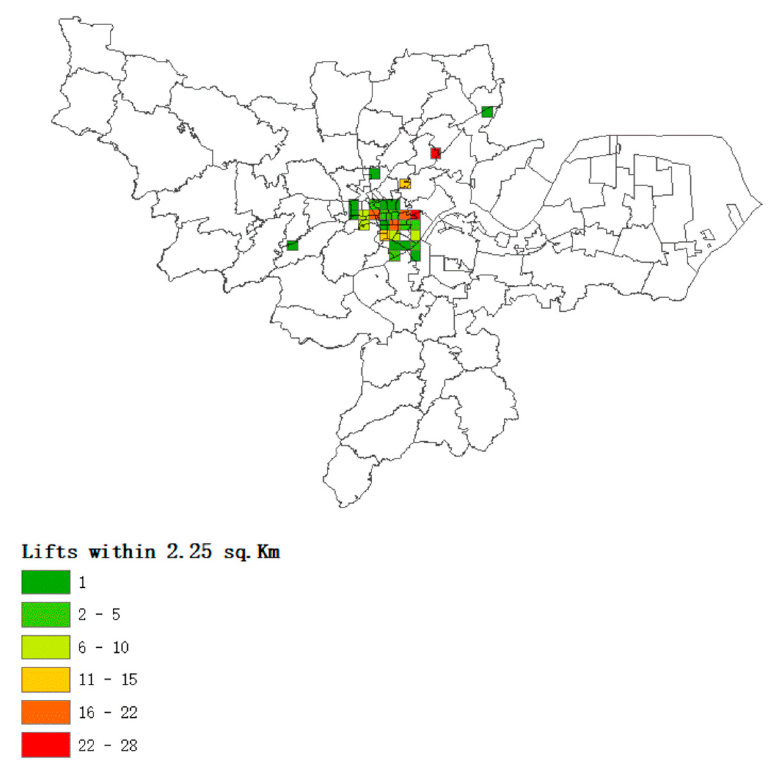
Figure 2. Fishnetting reveals the patterns of adoption of Lifts in 2018.